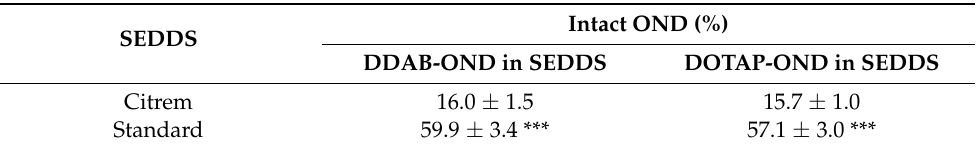
Table 7. Percentage of OND protected from degradation after 30 min of incubation in the presence of the S1